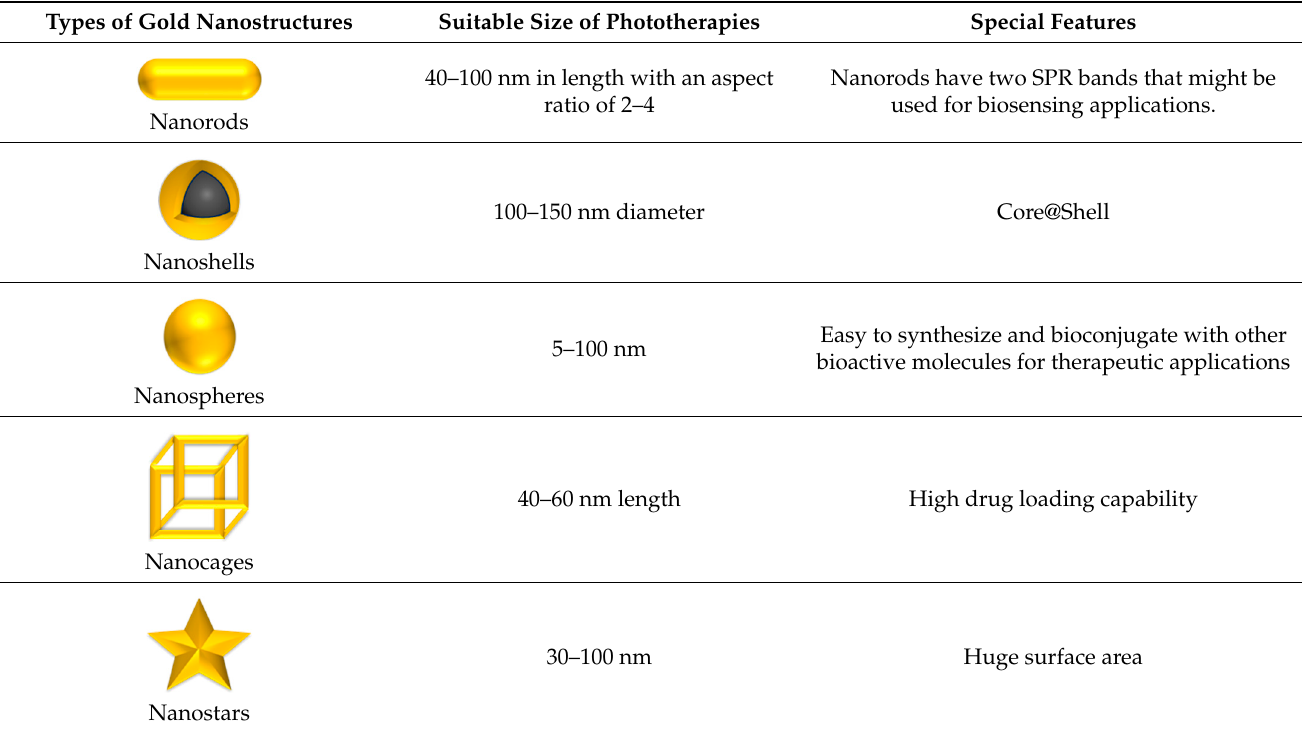
Table 1. The most common types of GNPs for efficient phototherapies application [75–78].